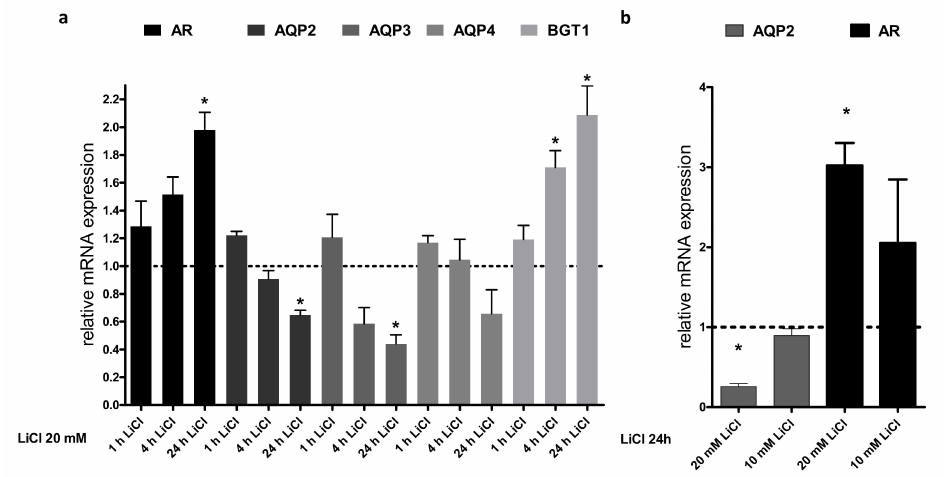
Figure 4. Downregulation of AQP2 mRNA by LiCl is time and concentration dependent. IMCD cells were treated for di ff erent time points with LiCl (20 mM). The mRNA expression of AQP2-4, BGT1, and AR was analyzed by real-time PCR and the relative changes compared to untreated cells were calculated ( a ). In the same way, IMCD cells were treated for 24 h with 10 or 20 mM of LiCl and the relative changes in the gene expression of AQP2 and AR were compared to untreated cells ( b ). One-way ANOVA analysis with Tukey post-test, * indicates statistically significant di ff erences to untreated cells ( p ≤ 0.05); n =